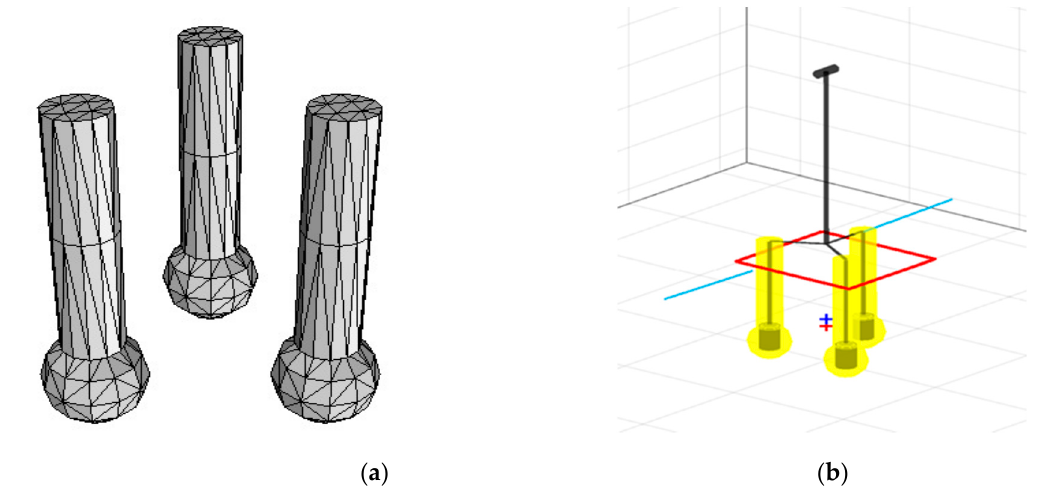
Figure 6. View of the WAMIT code models: ( a ) low order mesh considered in the WAMIT code analysis; ( b ) mooring setup in Edtools ® .